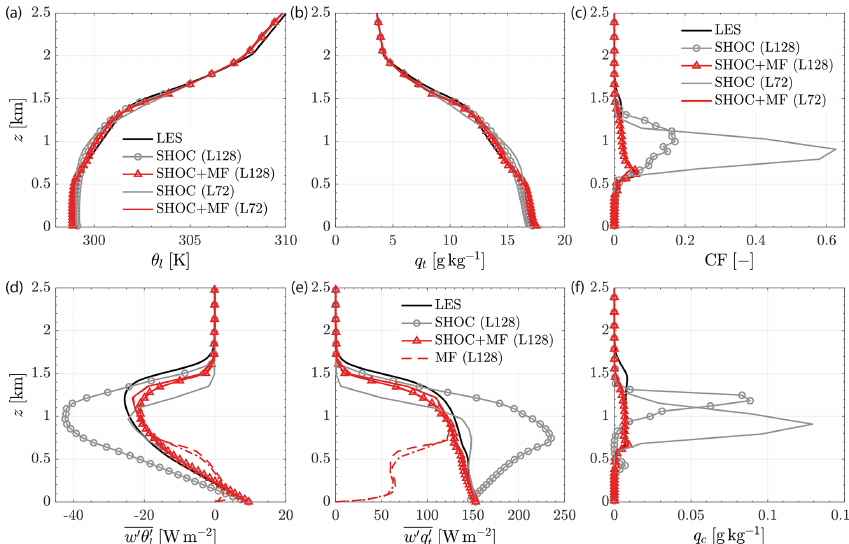
Figure 8. Sensitivity of the SCM results to the vertical grid resolution for the BOMEX case. Vertical profiles of (a) liquid water potential temperature, (b) total water mixing ratio, (c) cloud fraction, (d) turbulent heat flux, (e) turbulent moisture flux, and (f) cloud water mixing ratio for LES (solid black line), SHOC (solid grey line), SHOC + MF (solid red line), and MF (dashed red line). The high-resolution vertical grid (L128) profiles are represented by solid lines with markers (circles for SHOC and triangles for SHOC + MF), whereas the coarse-resolution vertical grid (L72) profiles are presented by plain solid lines. The dotted–dashed and dashed red profiles represent the MF contribution using L72 and L128, respectively. The profiles correspond to a time average over t = 4–6h.